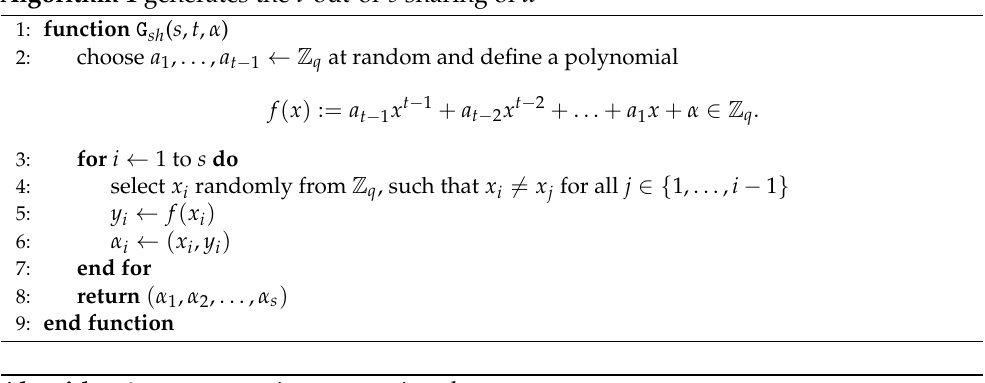
Algorithm 1 generates the t -out-of- s sharing of α